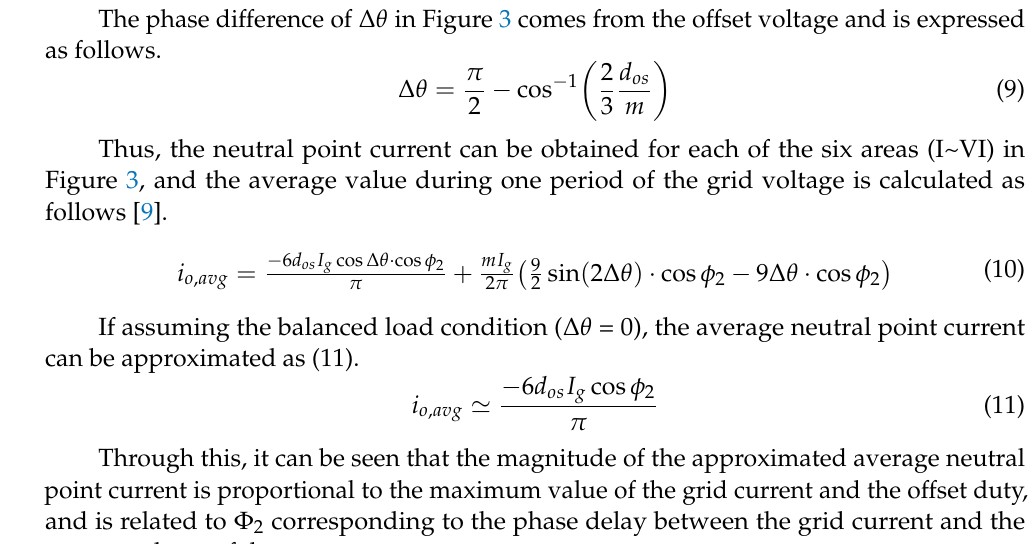
Here, the i p and i n are the positive and negative side instantaneous output current, respectively.